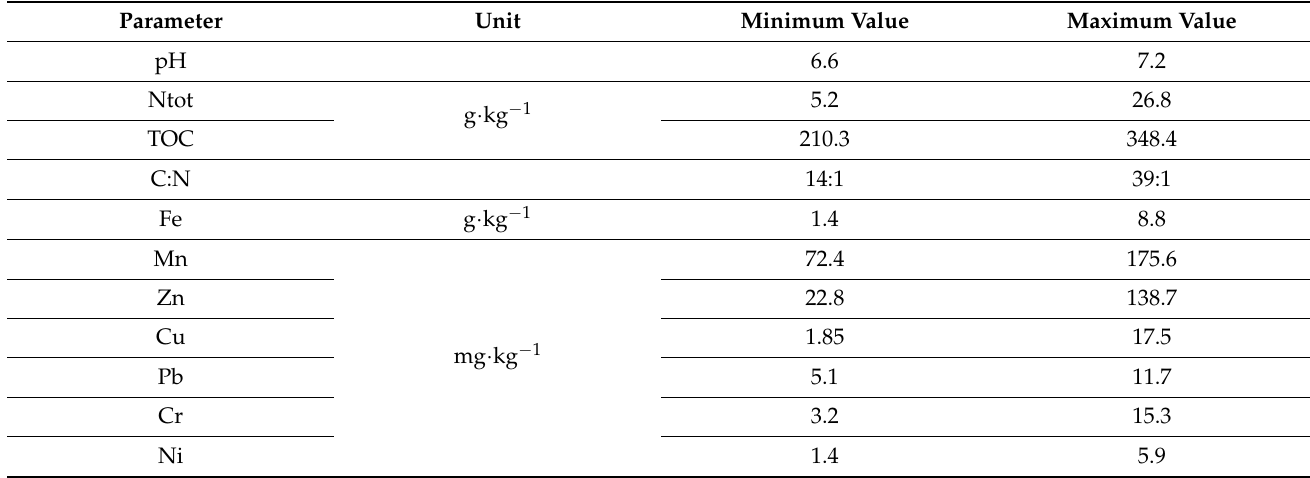
Table 1. Chosen parameters of raw materials used for composting